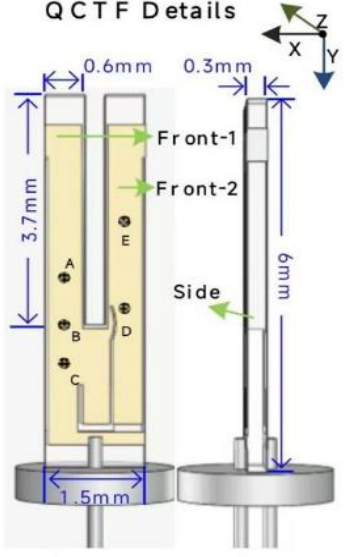
Figure 3. Structural model diagram of the